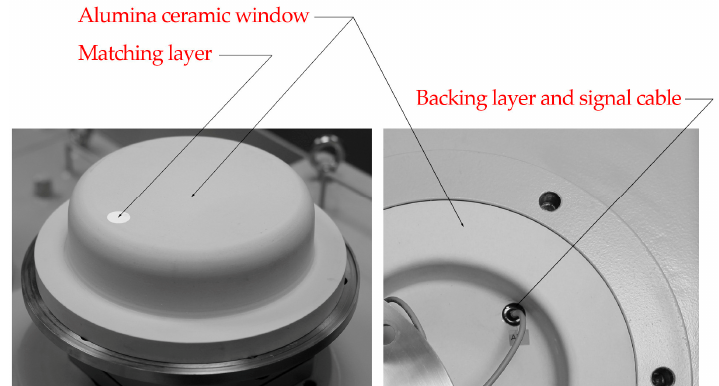
Figure 3. Photographs of the active dielectric window produced.